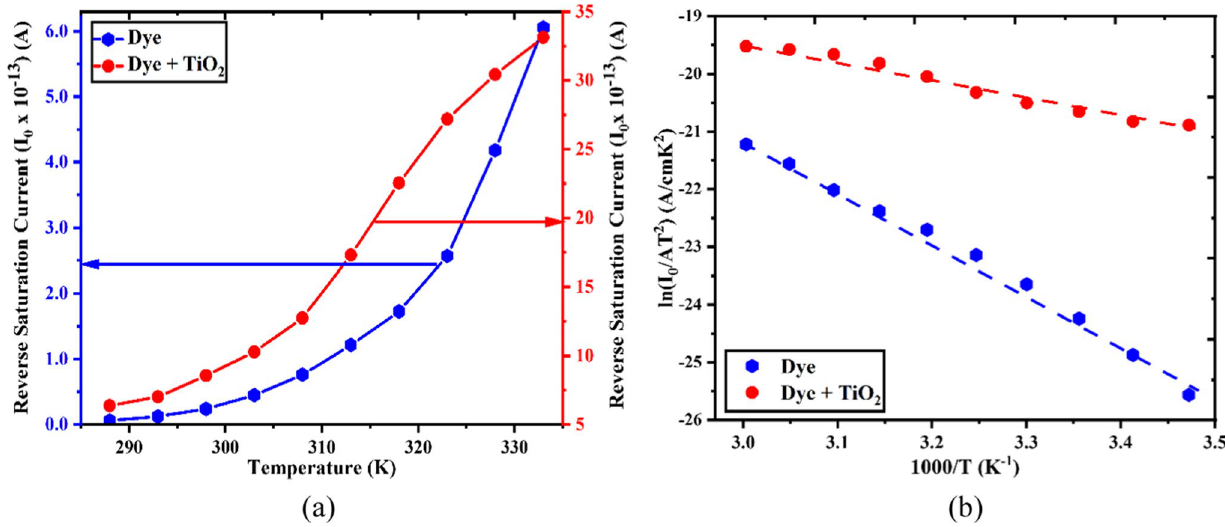
Fig.5 a Extracted plot of Dependency of I